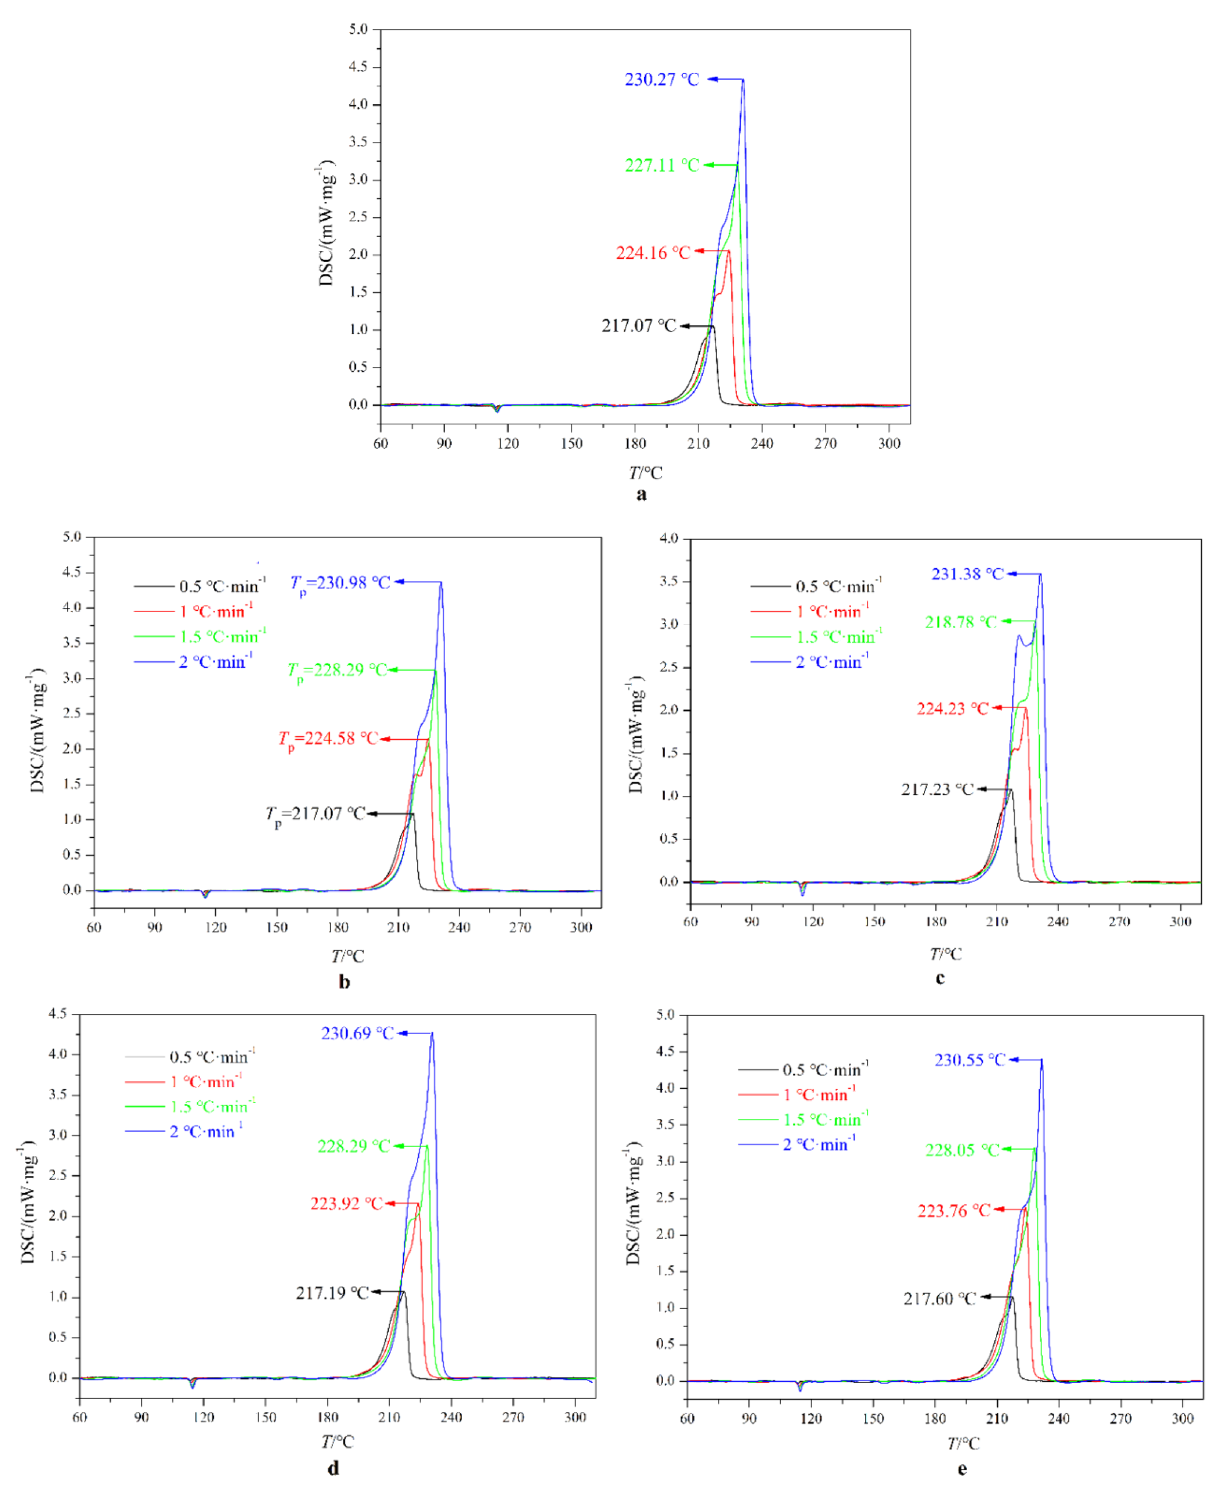
Figure 7. DSC curves of HNIW/FOX-7 based PBX samples. ( a ) Untreated, ( b ) HLC treatment, ( c ) LT treatment, ( d ) HT treatment, ( e ) HLS